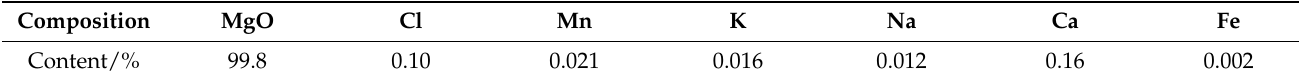
Table 3. Basic parameters of